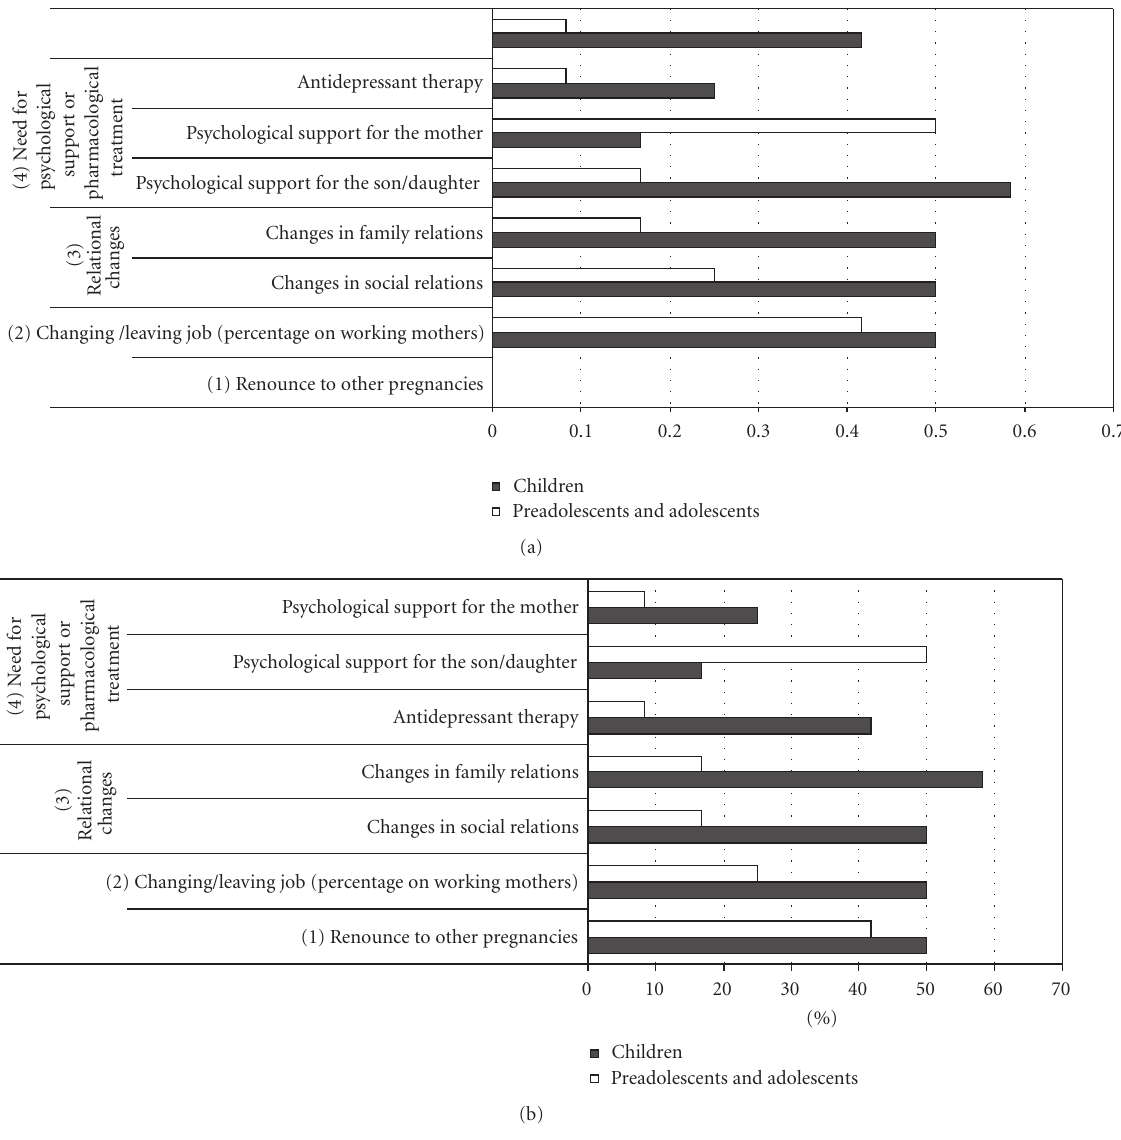
Figure 1: Changes in family